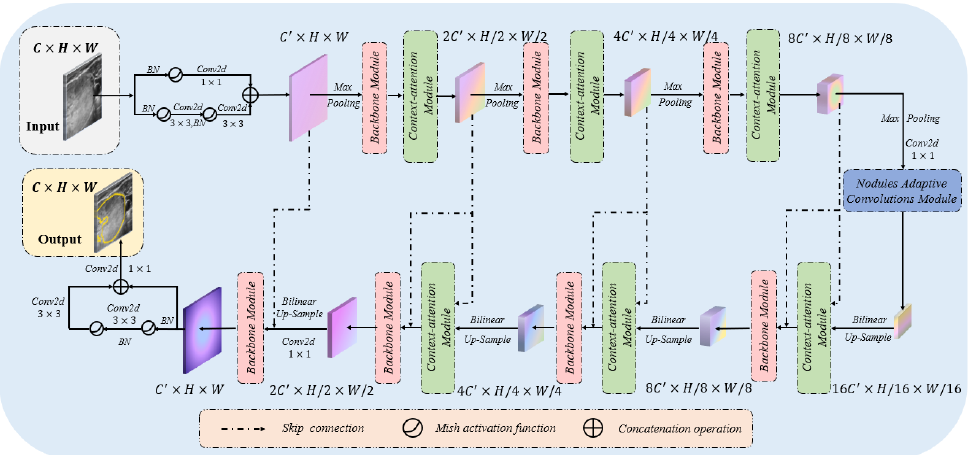
Figure 1. Illustration of the proposed local and context-attention adaptive network (LCA-Net) for the thyroid nodule segmentation of ultrasound images. The LCA-Net has the structure of an encoder and decoder. It mainly contains the backbone modules, context-attention modules and a nodule adaptive convolutions module, which could extract local details and global context information. See the text for more